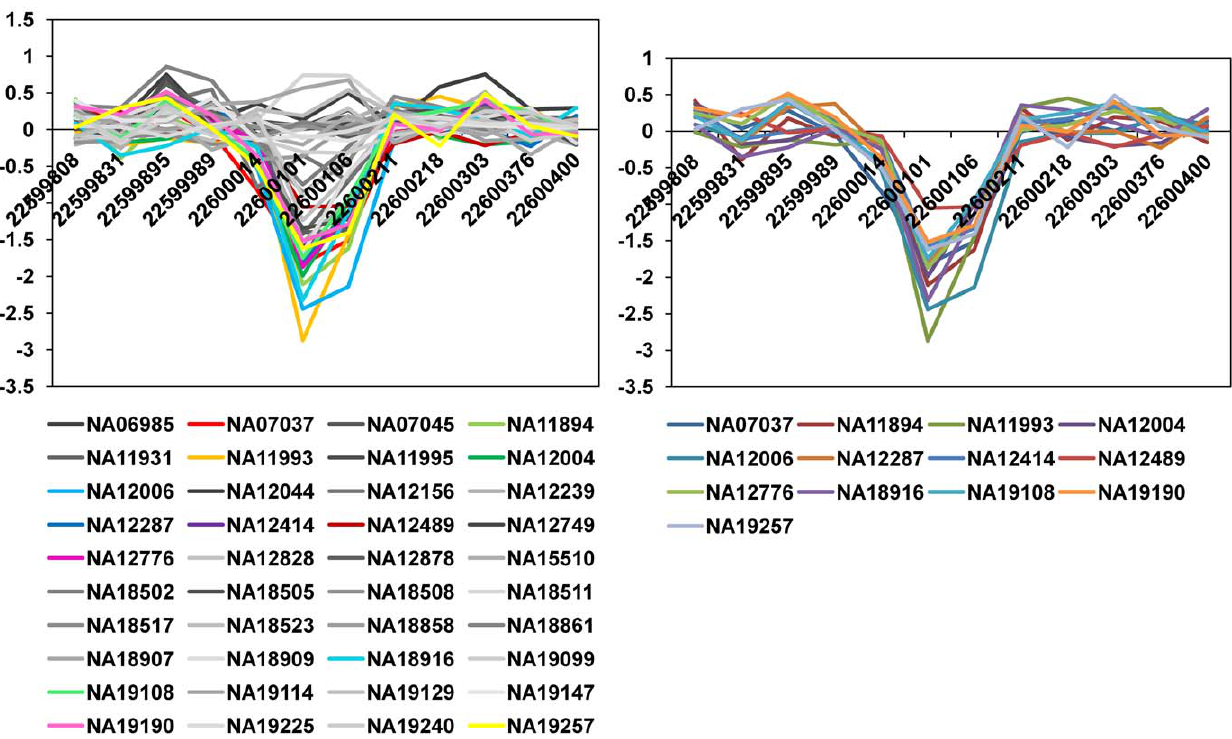
Figure 3. An example of the CNVZ results obtained chromosome 22 using optimal parameters. The graph shown in the left-panel indicates the raw log ratio profile pattern of CNVZ. In the left-panel and right-panel, the colored lines indicate the samples that participate in the CNVZ. The right-panel only shows the samples that participate in the CNVZ. Among 40 samples, 13 samples are turned out to be CNVs in this result.